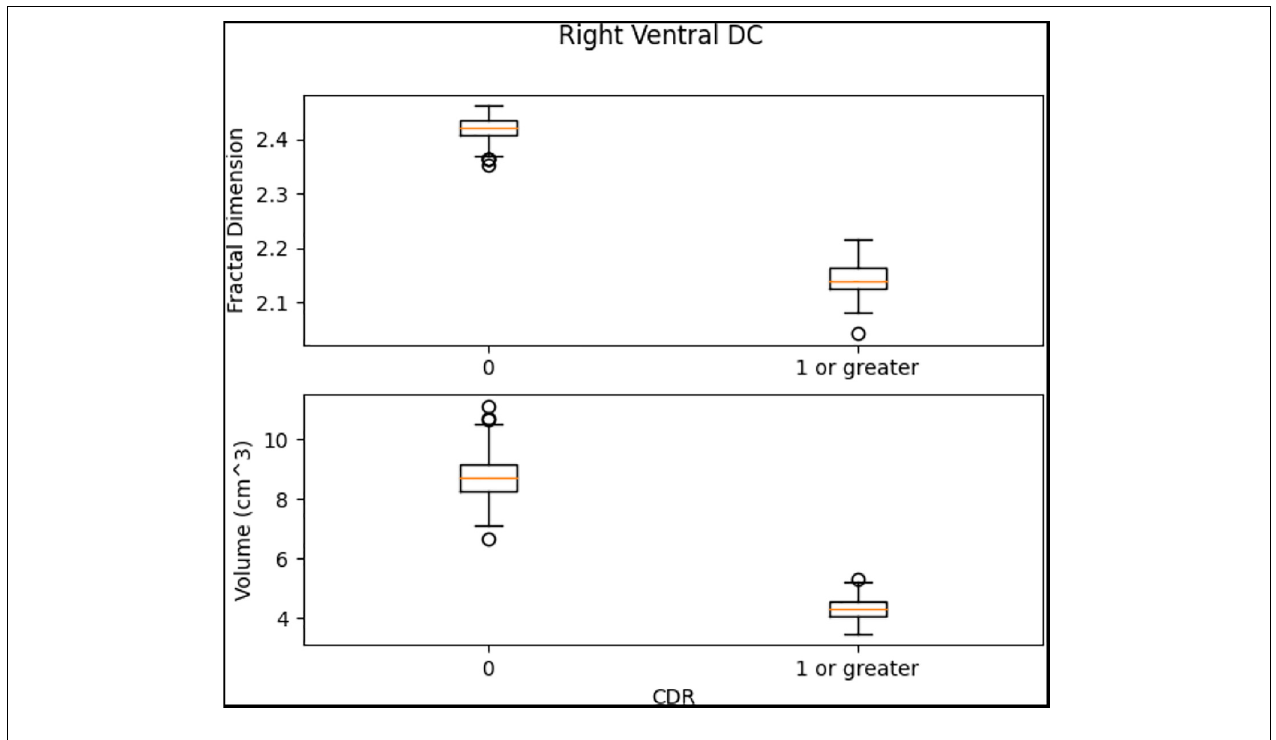
FIGURE 17 | The box plots for Right Ventral DC region.